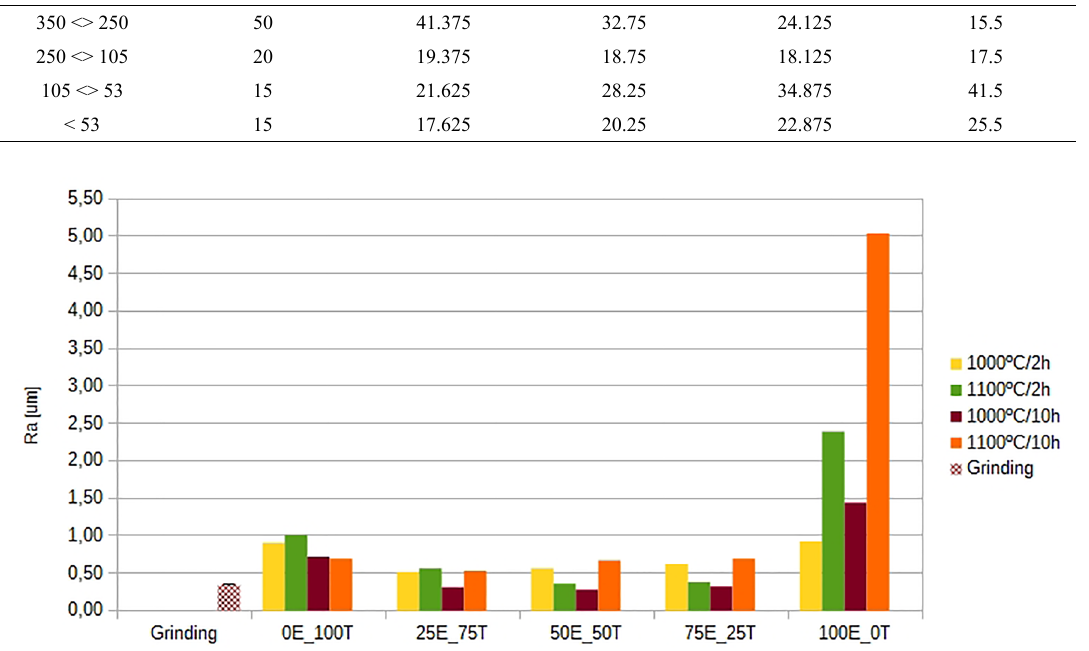
Figure 1. Comparative roughness values of the samples before/after thermochemical